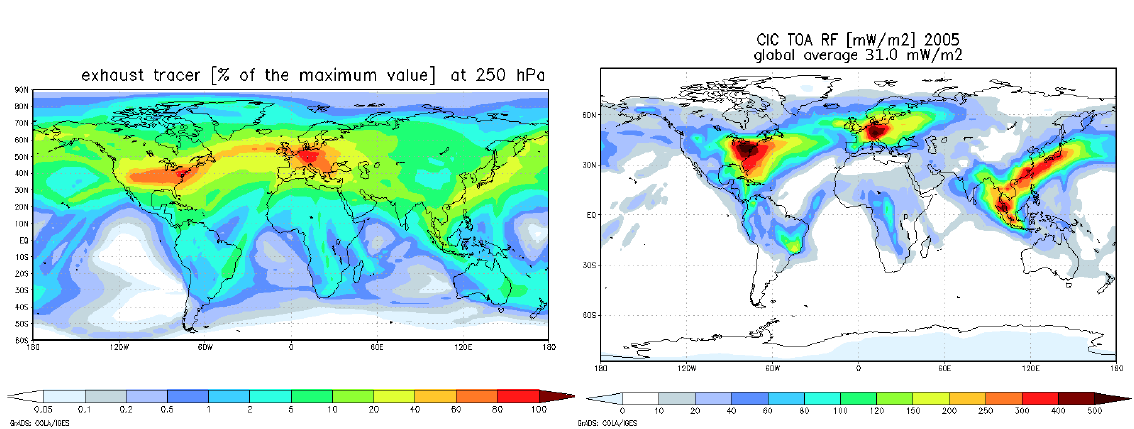
Fig. 3. On the left, annual mean horizontal distribution of the contrail tracer at 250hPa as percentage of the maximum value. On the right, annual average TOA radiative forcing of CIC in mWm − 2 . Both figures are for the year 2005.